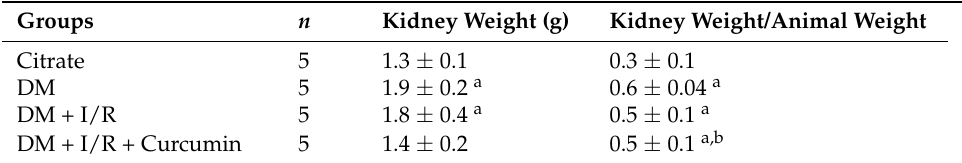
Table 3. Kidney weight and body weight/animal weight ratio.